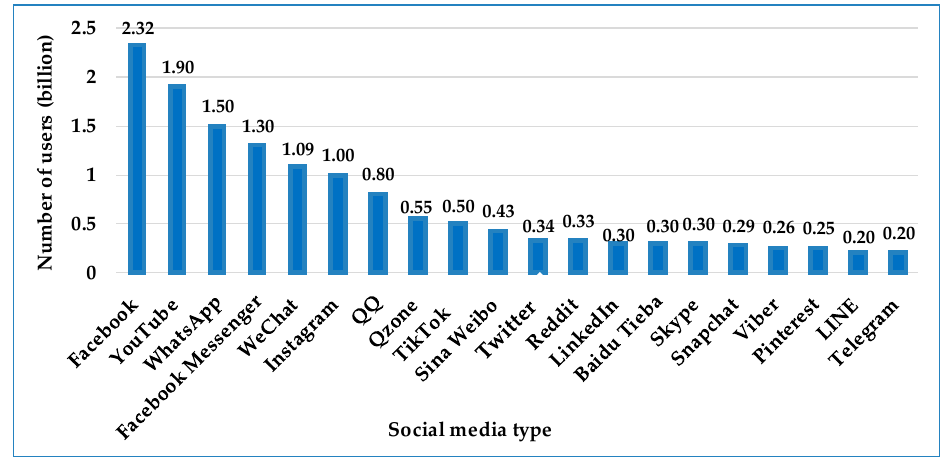
Figure 2. Globally distributed number of users using social media networks [4].